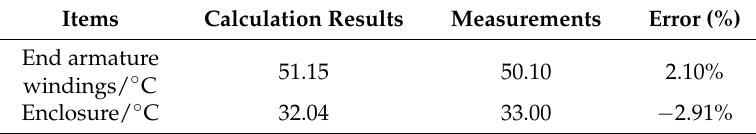
Table 5. Comparison of Calculation Results with Measurements under rated torque and 0 At AMMF.